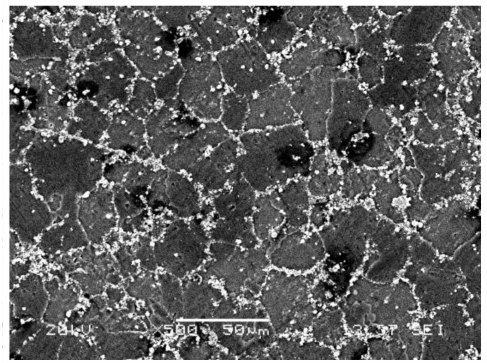
Figure 1. Microstructure of TiB 2 /7050Al MMC.